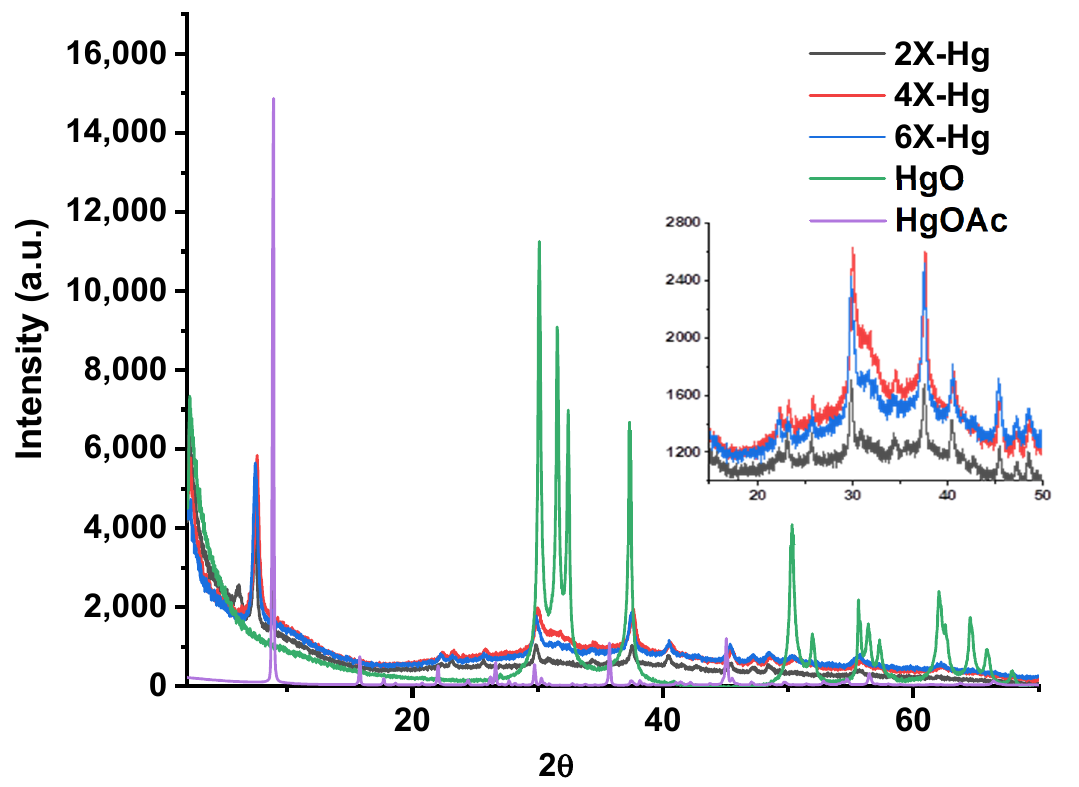
Figure 10. X-ray diffractograms of the xerogels at the end of the mercury recovery experiment compared with the diffractogram of HgO deposited on the vials (confirmed by similarity with diffraction card 2310656) and that of Hg(CH 3 COO) 2 .